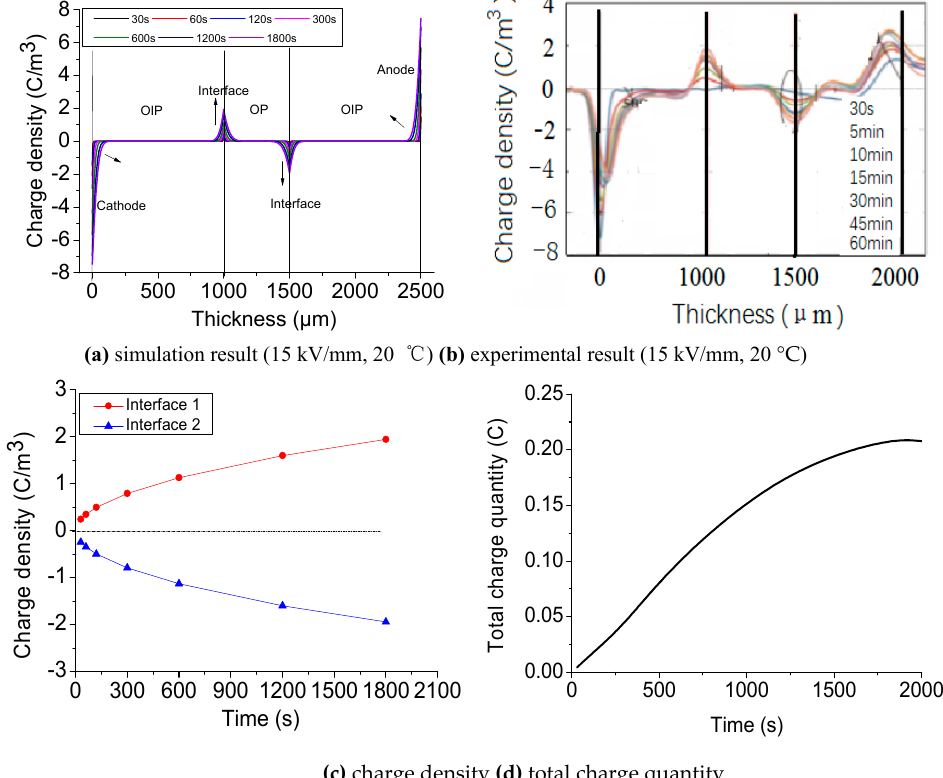
Figure 3. Space/interface charge simulation and PEA measurement result for three-layer “OIP+ OG + OIP” (15 kV/mm, 20 °C).